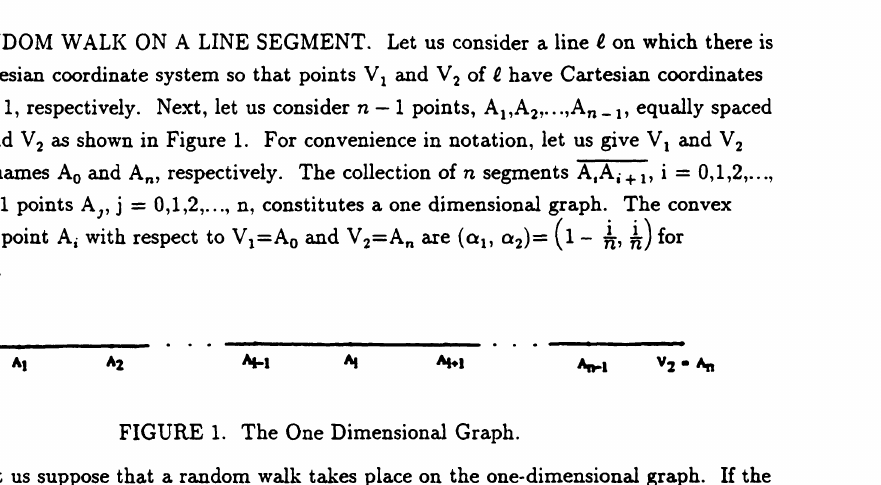
FIGURE 1. The One Dimensional